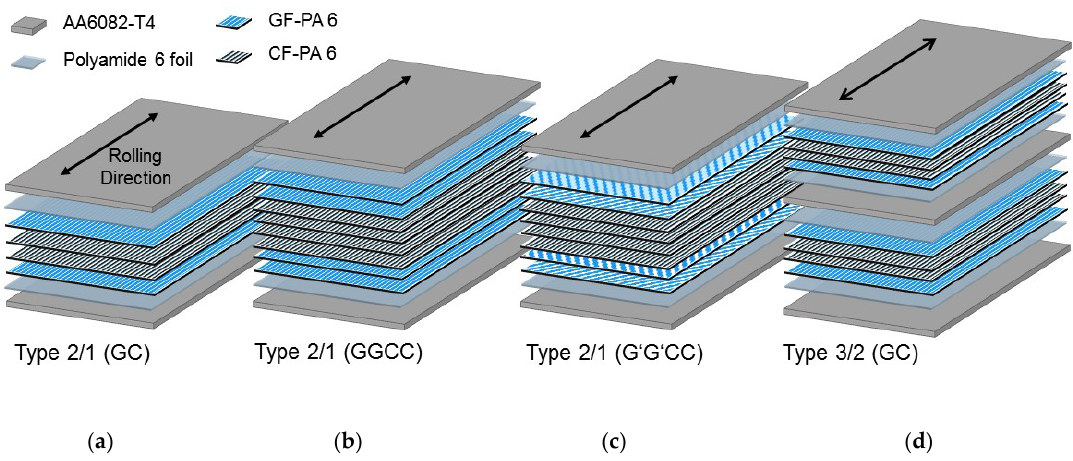
Figure 1. Material composition of the hybrid laminates: ( a ) 2/1 (GC) with four fibre-reinforced plastic (FRP) layers, ( b , c ) 2/1 (GGCC) with eight FRP layers but different glass FRP (GFR-PA6 orientations (±45° for 2/1 (G ′ G ′ CC)), and ( d ) 3/2 with 2× four FRP layers between aluminium sheets.